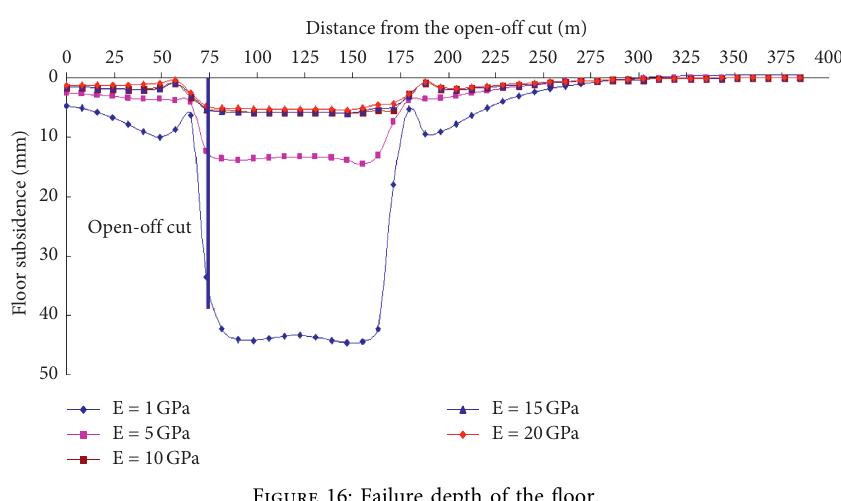
Figure 16: Failure depth of the floor.